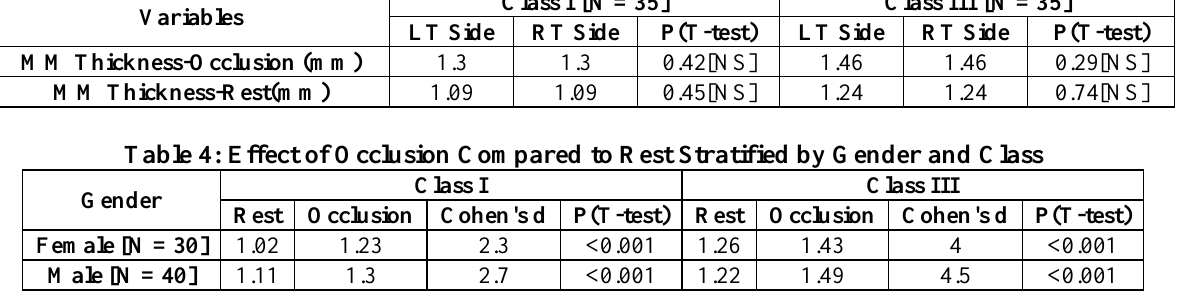
Class III [N = 35] Class I [N = 35]